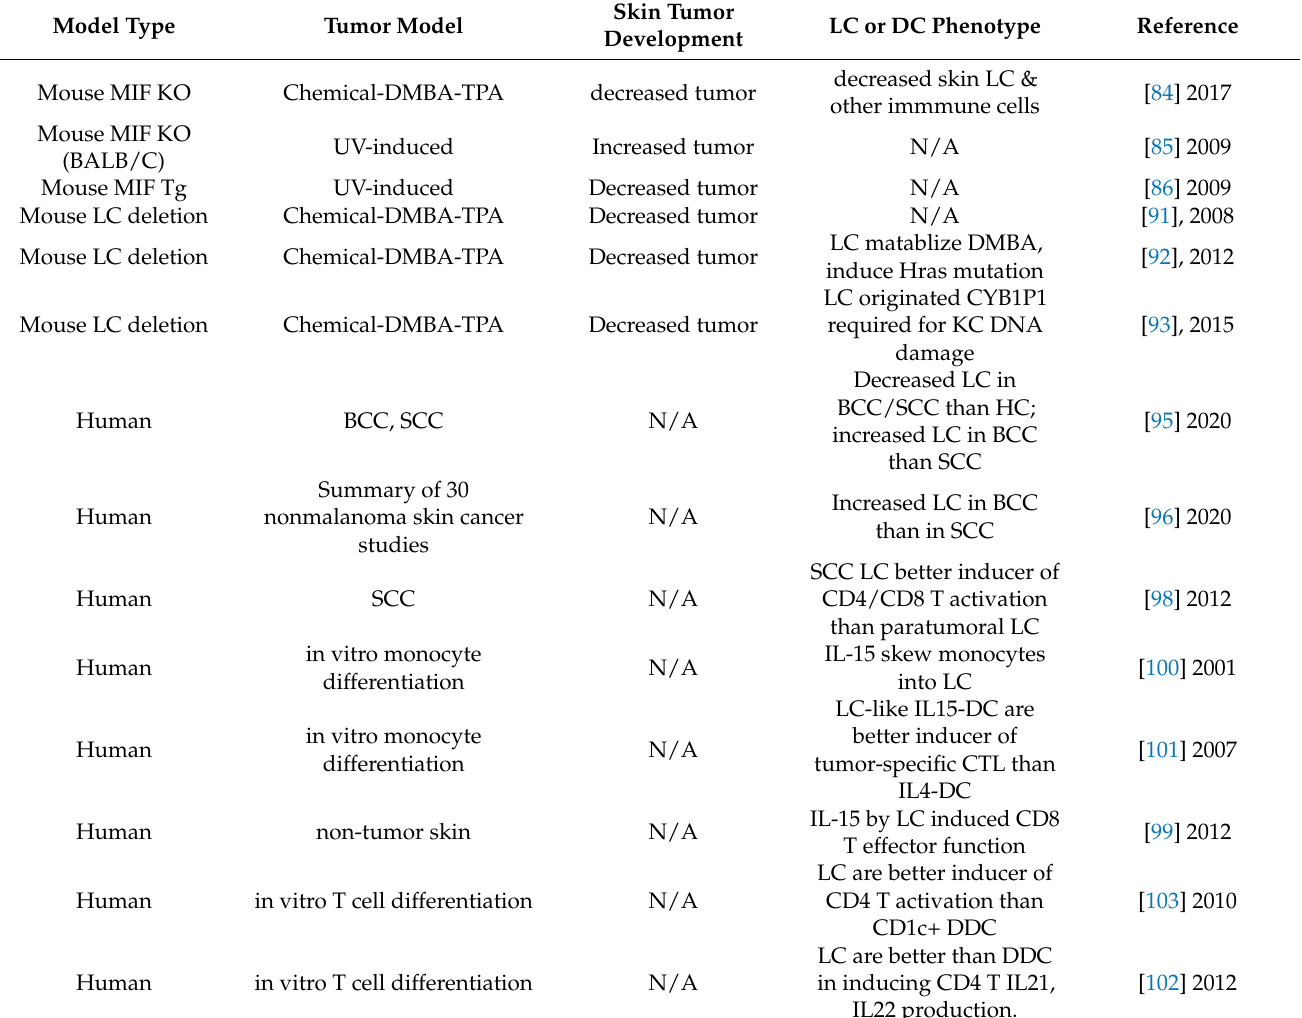
Table 2. Langerhans cells in murine skin tumor models and human skin